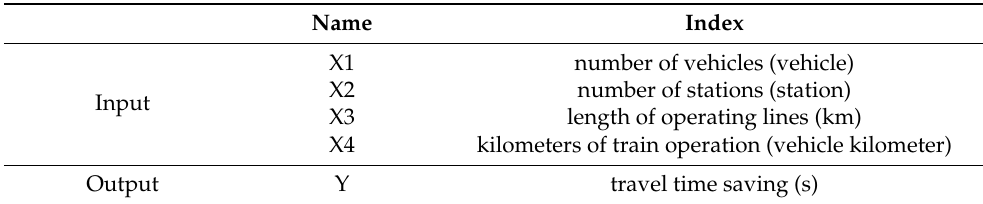
Table 8. DEA Input-output of Network Transport Efficiency.